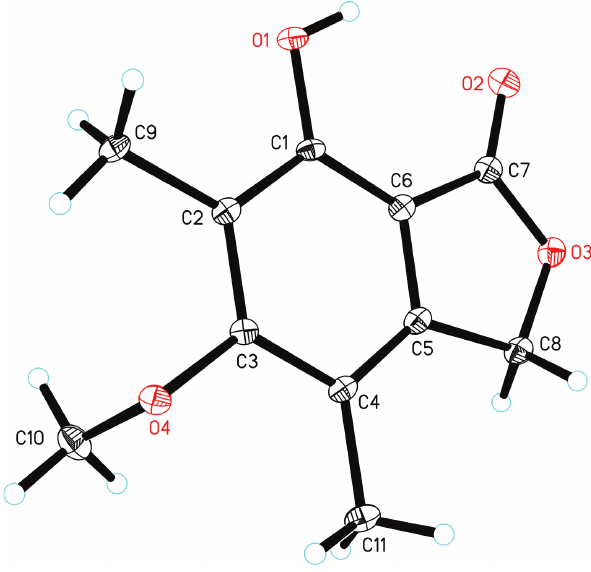
Table 1: Data collection and handling.